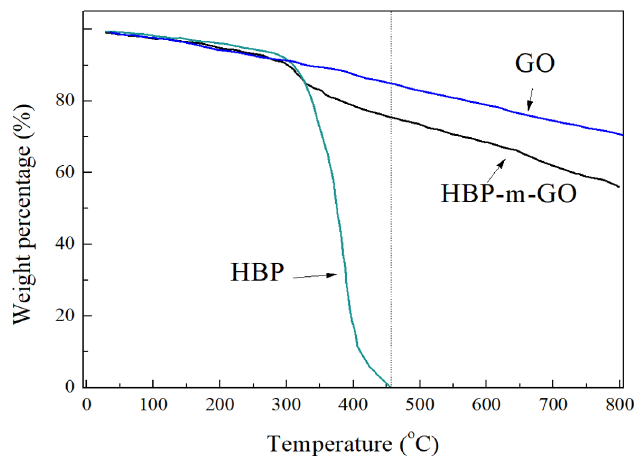
Figure 4. TGA results of HBP, GO, and HBP-m-GO.